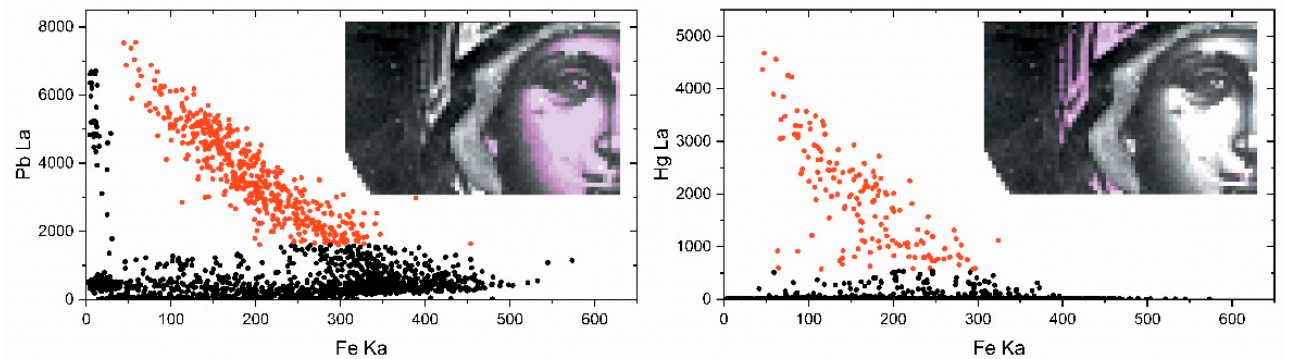
Figure 4. Transitions intensity scatter plots to derive spatial correlations. Left : Pb La relative to Fe K α . Red scatter points correspond to measurement points over the Virgin’s highlighted part of the face. Right : Hg L α relative to the Fe K α intensity. Red scatter points correspond to measurement points over the highlighted part of the mantle.